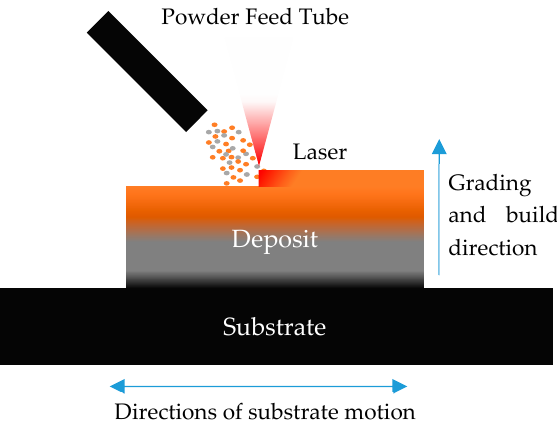
Figure 1. A schematic representation of the LMD deposition process used in the study. The gradient in the deposit illustrates the grading within the deposit; the different colors in the powder particles are used to represent blended powder feedstock.